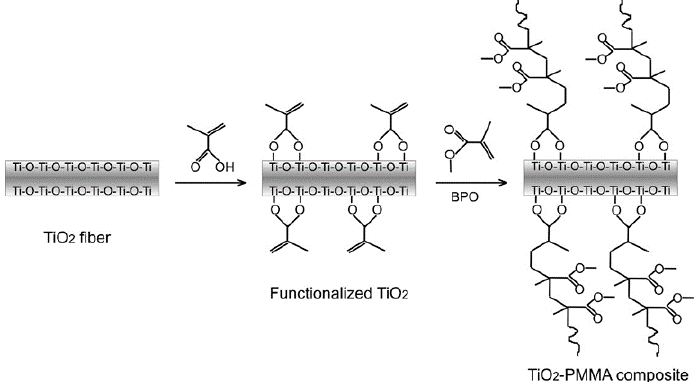
Figure 5. Schematic of functionalization of TiO 2 and formation of TiO 2 -PMMA nanocomposite. Reproduced from Ref. [85] with permission from the ACS, 2007.